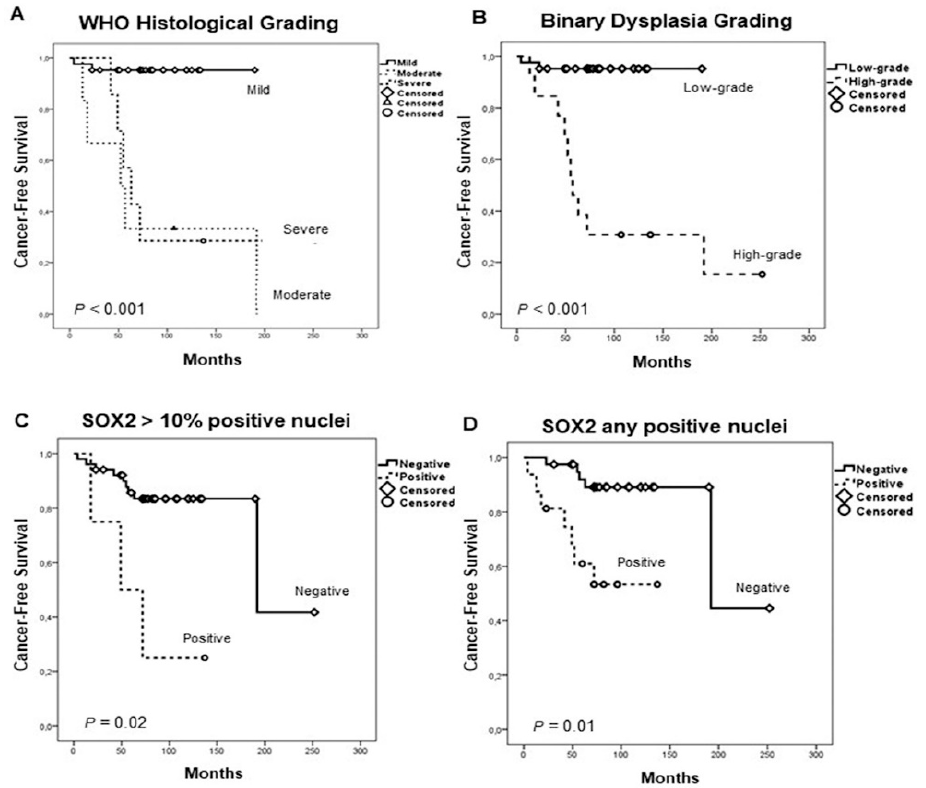
Figure 2. Kaplan–Meier cancer-free survival curves in the cohort of 55 patients with oral epithelial dysplasia categorized by the World Health Organization (WHO) histological grading ( A ), the binary dysplasia grading ( B ), and SOX2 protein expression dichotomized using the cut-off values of SOX2 staining > 10% positive nuclei ( C ) or SOX2 staining any positive nuclei ( D ). Table 2. Evolution of the premalignant lesions in relation to histopathological diagnosis and SOX2 expression.